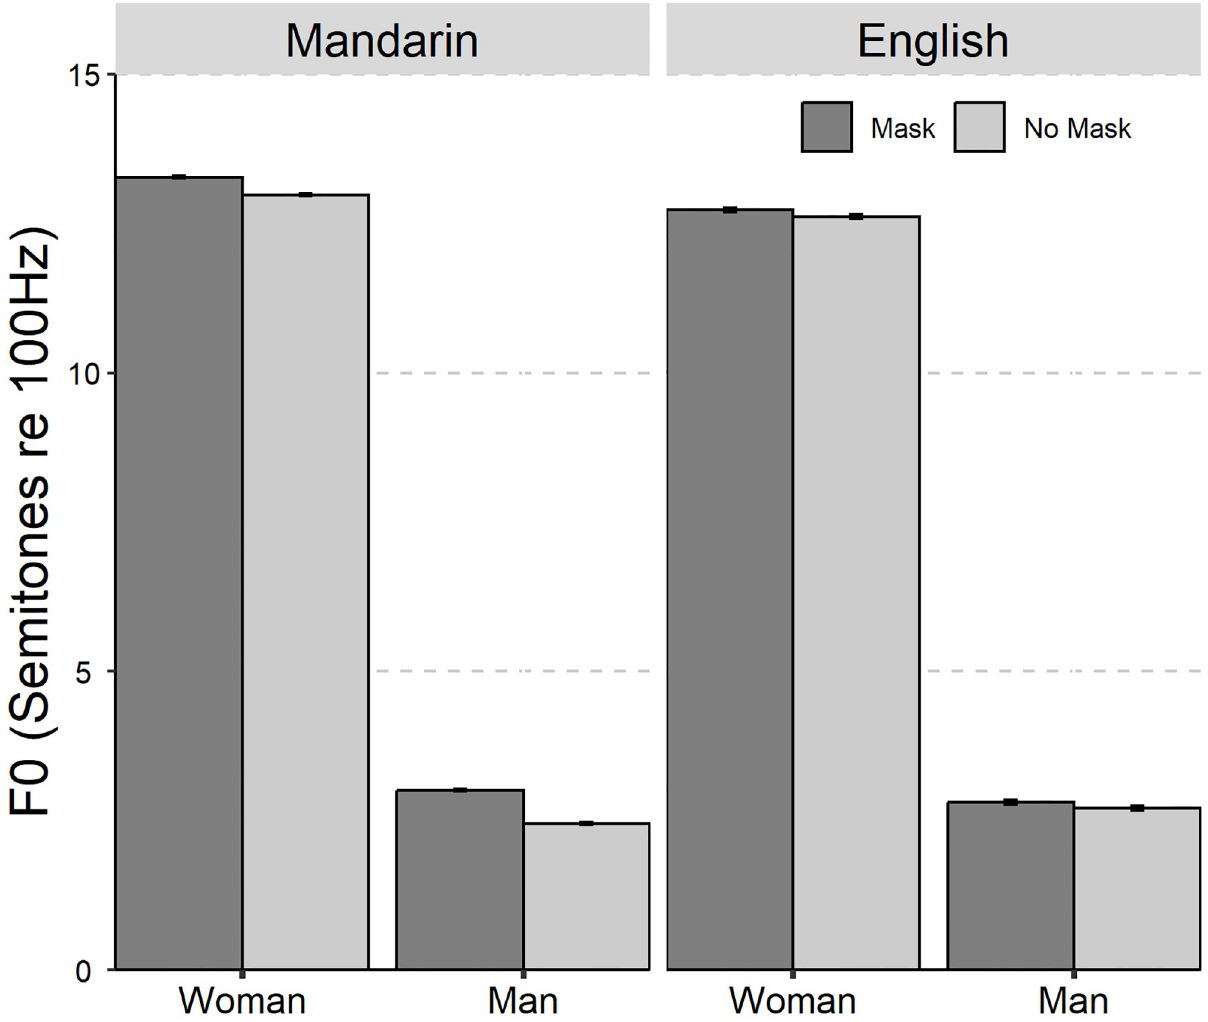
Fig 1. The bar plot (with standard error) of the fundamental frequency (in semitones with a reference of 100 Hz) of Mandarin Chinese and English with and without mask across gender (female and male).